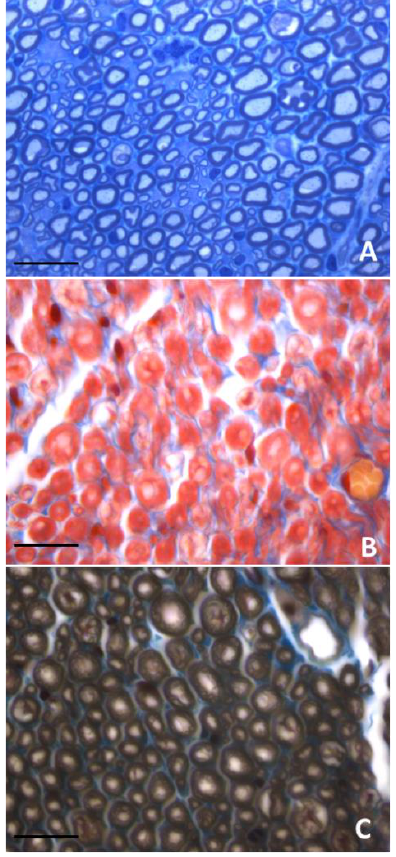
Figure 2. Transverse sections of healthy peripheral nerves subjected to different tissue processing and staining. ( A ) Toluidine blue staining of resin-embedded semithin sections; ( B ) trichrome staining of paraffin embedded sections; ( C ) trichrome and osmium staining of paraffin embedded sections. Scale bars: 20 μ m.